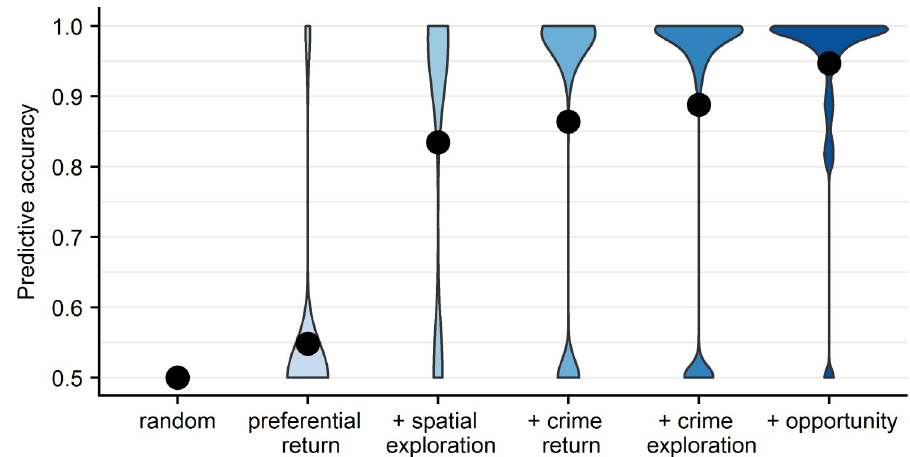
Fig 4. Accuracy of the predictions. A simple and intuitive measure of model fit is the proportion P of potential crime locations with a lower predicted probability than the actual crime location. P = 1 in case of a model with perfect prediction, while P = .5 in case of random choice. Increasing model complexity along the horizontal axis improves predictive quality (black dots). The shape of the density (blue ‘hourglasses’) of the accuracy measure P show thats its distribution is bimodal, and that model fit improvement is a function of individuals ‘jumping’ from the ‘almost random’ category to the ‘near-perfect’ category when variables are added to a model. The accuracy measure P correlates .96 with McFadden’s R2, a common but less interpretable measure of model fit. In S15 Table I present the results of a parsimonious model that uses continuous measures of time use and proximity. This model cannot test all hypotheses, but its predictions are almost equally accurate (P = .94) as those of the most comprehensive model presented here (“+ opportunities”, P = .95).